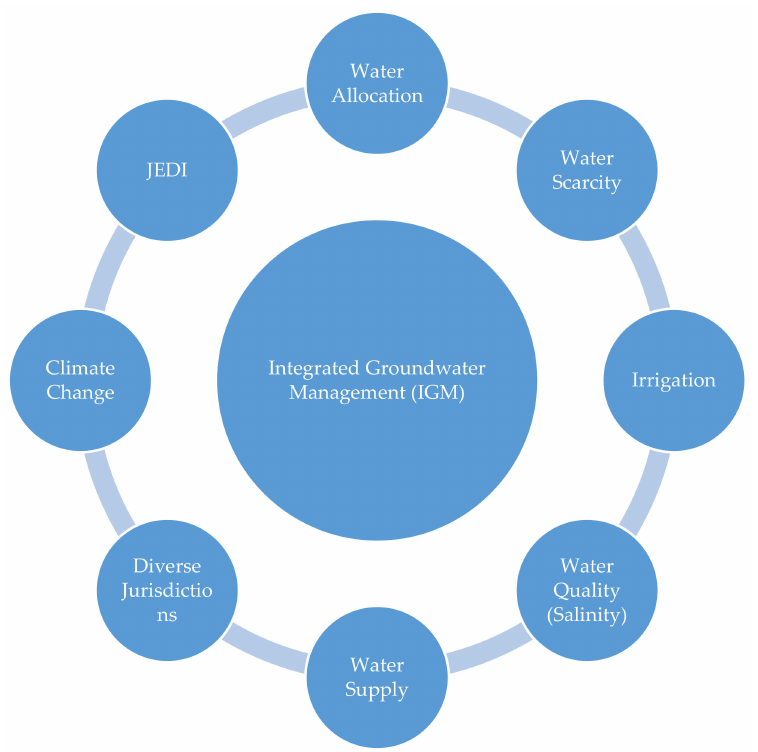
Figure 5. Problem space for integrated groundwater management (IGM). Modeling tools and other decision support tools should address the whole problem space. JEDI is used to represent justice, equity, diversity, and